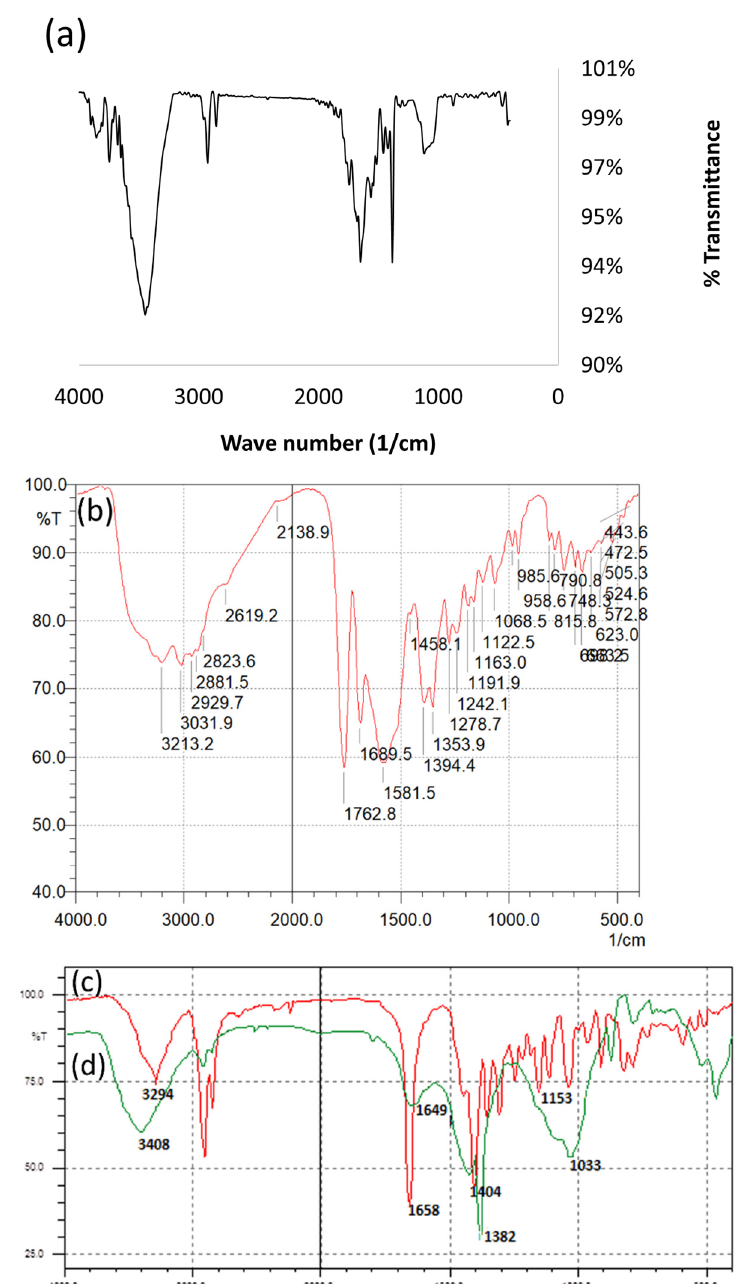
Figure 2. Representative spectra of FT-IR of Ceph-AgNPs ( a ); Vgt-AgNPs ( b ); shows the presence of hydroxyl, lactam, carboxylic acid and amino groups. However, while compared with drugs alone ( c , d ), hydroxyl groups peaks showed a shift in wave number which indicates the interaction with silver nanoparticles. Spectra were recorded at Bruker Vector 22 instrument using Potassium bromide (KBr) disc method.